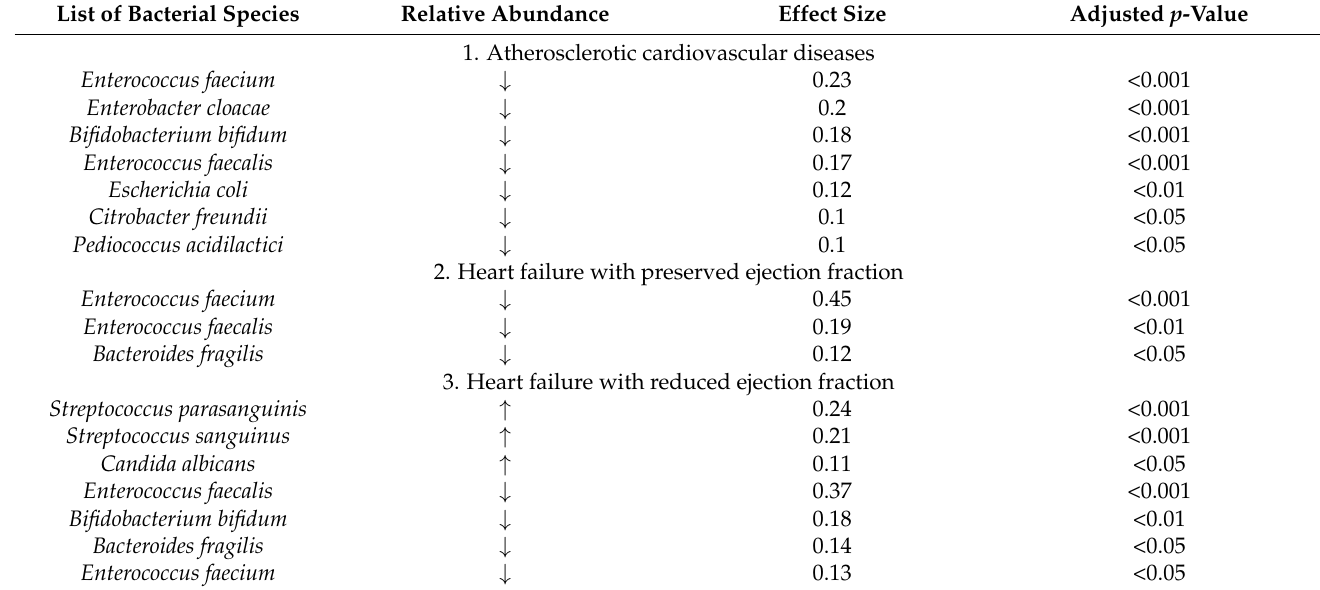
Table 6. Results of MALDI-TOF MS analysis. Arrows indicate increase ( ↑ ) or decrease ( ↓ ) in the patients